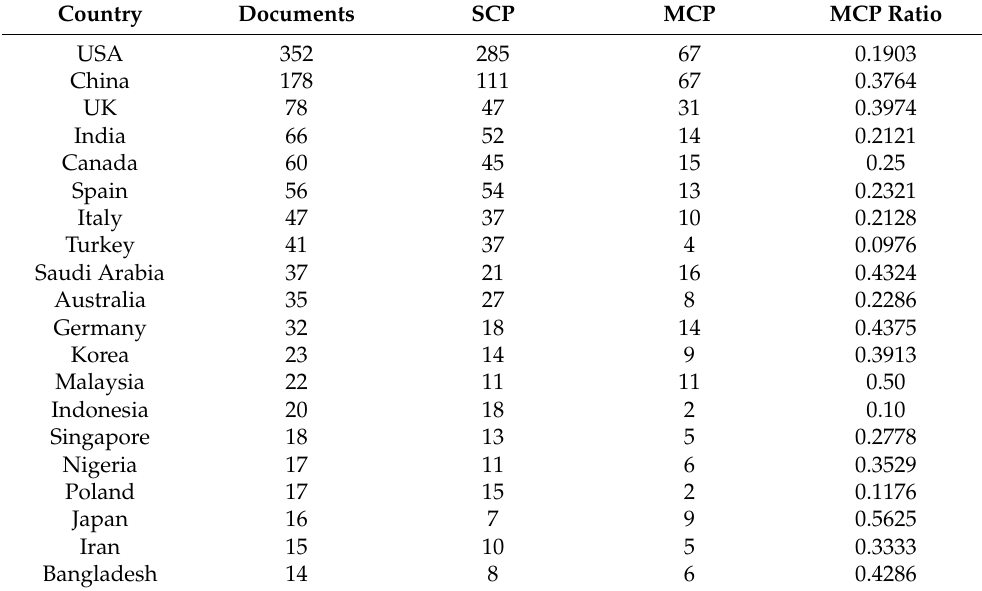
Table 6. Top 20 most productive countries.